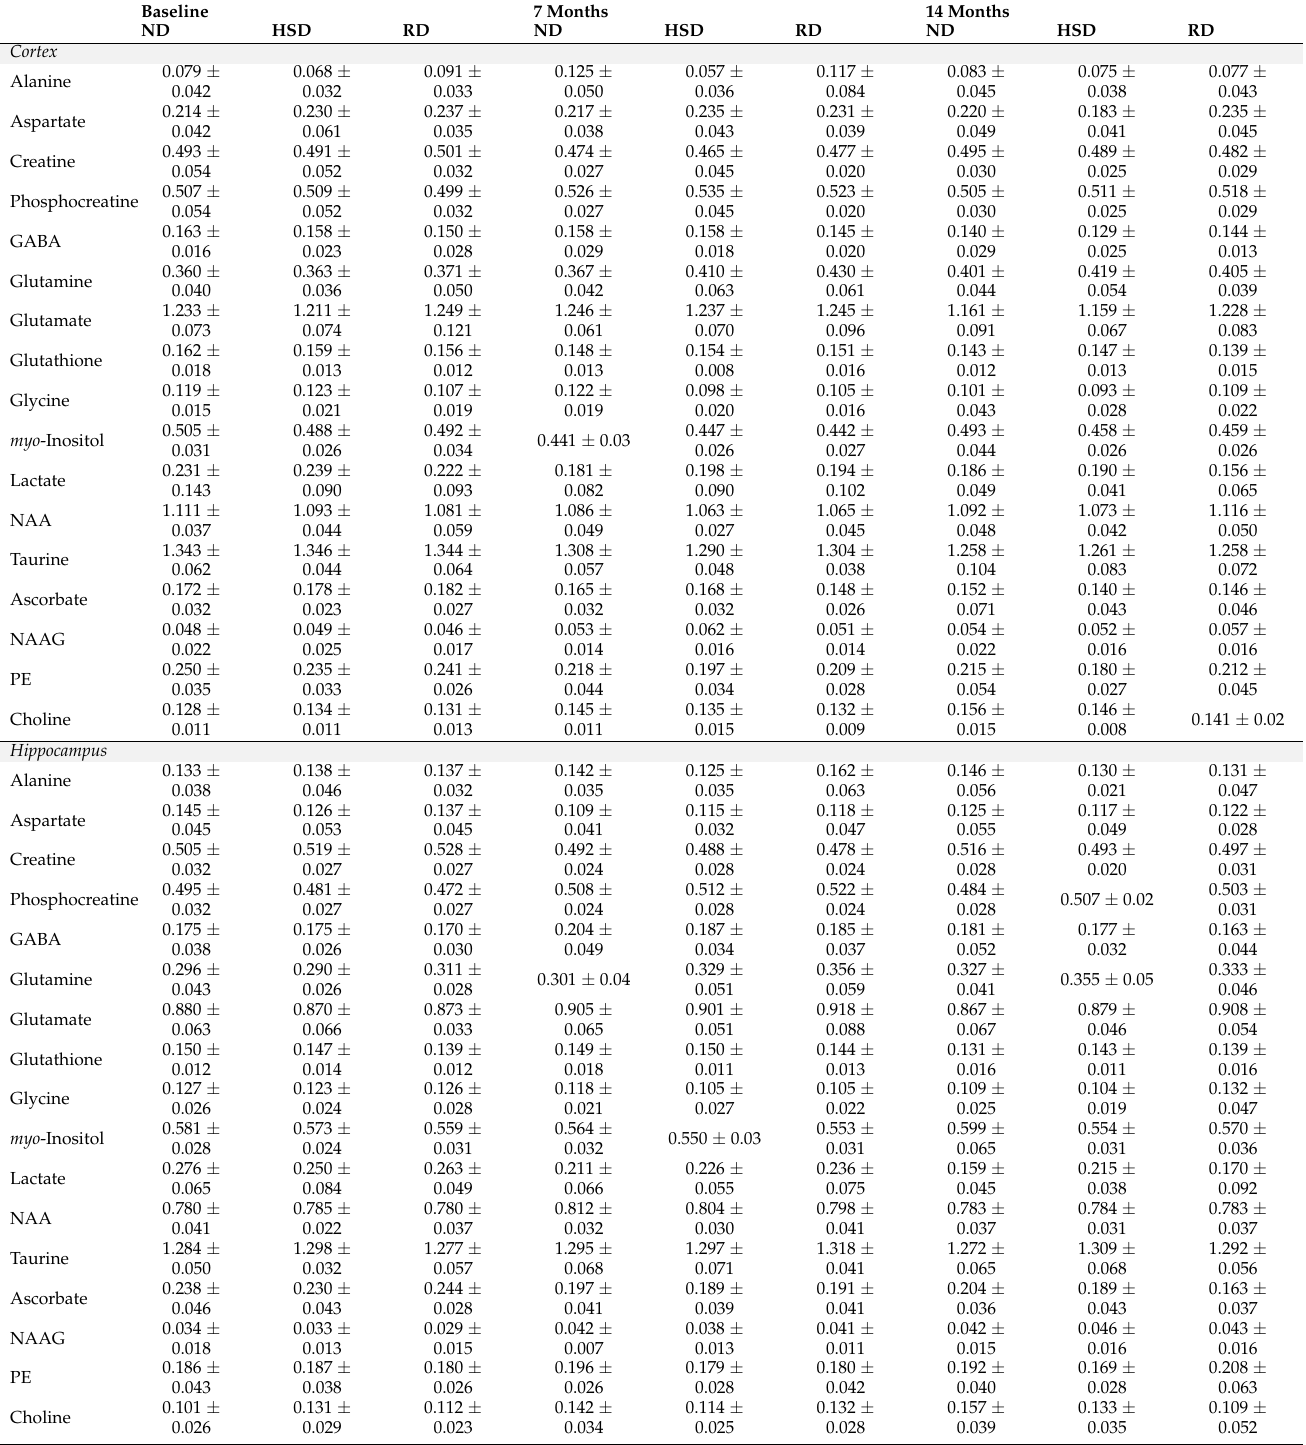
Table A2. Metabolite concentrations expressed as ratios to total creatine (means ±